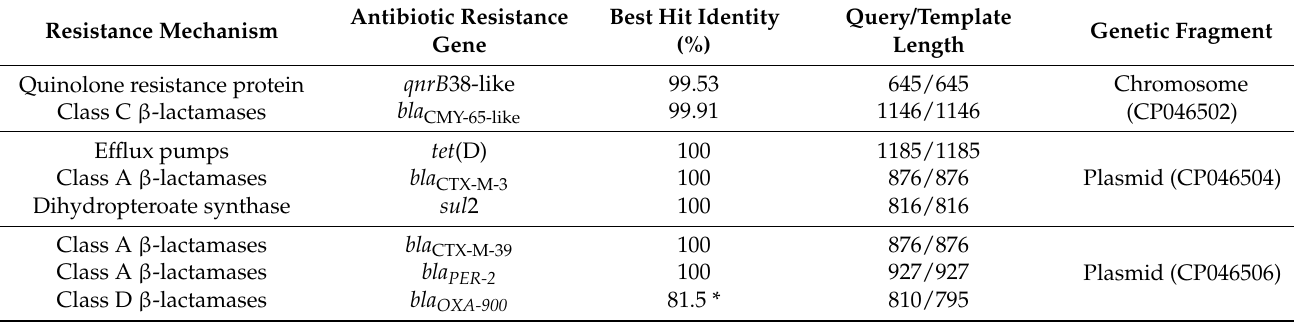
Table A1. Resistance genes found on genomic fragments assembled from C. freundii ISCF142. Resistance